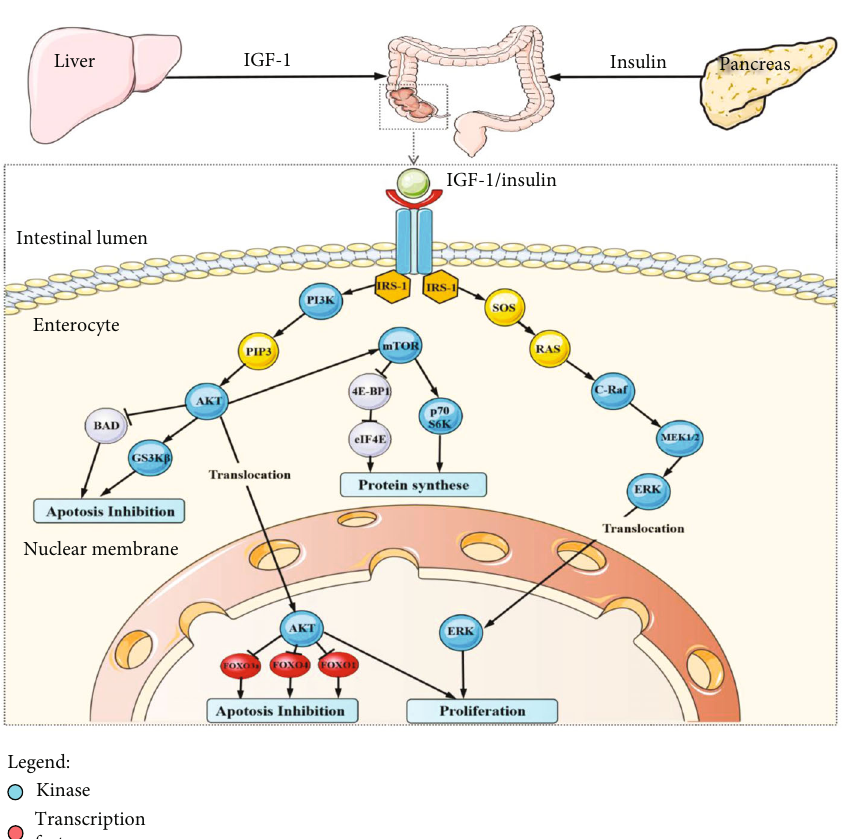
Figure 1: Schematic review of the tumor-promoting signaling pathways linking hyperinsulinemia and CRC. IGF-1R is comprised of extracellular α -chains, transmembrane β -chains and intracellular tyrosine kinase (IRS-1). Both IGF-1 and insulin are ligands for IGF-1R, and their binding induces autophosphorylation and conformational change of cytoplasmic tyrosine domain, resulting in stimulation of signaling cascades, mainly including PI3K/AKT and MAPK pathways which are closely correlated with protein synthesis, survival, and proliferation. IRS-1: insulin receptor substrate-1; PI3K: phosphatidylinositol 3-kinase; AKT: protein kinase B; mTOR: mammalian target of rapamycin; MAPK: mitogen-activated protein kinase; MEK: mitogen-activated protein kinase; ERK: extracellular signal-regulated kinase; SOS: son of sevenless; FOXO: Forkhead; BAD: proapoptotic member of the Bcl-family; GS3K β : glycogen synthase kinase.